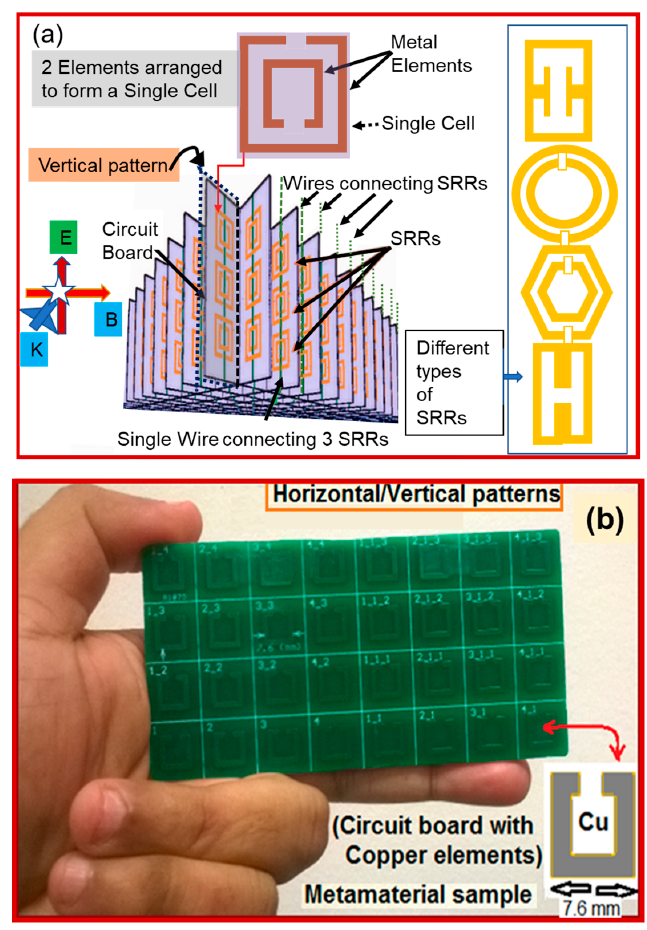
Figure 2. Typical examples ( a ) various orientations of SRR on a circuit board, and ( b ) rectangular metamaterial sample.